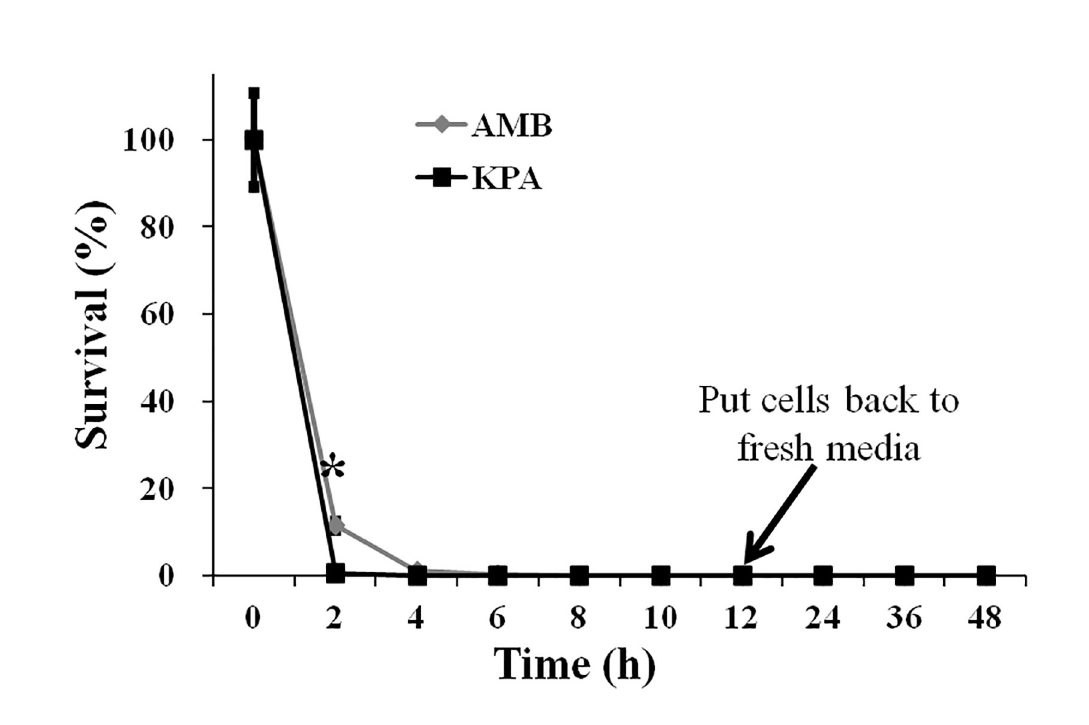
Fig 2. The time-killing curves of KPA and AMB against wild type C . albicans strain SC5314. Data represent mean values and error bars show standard deviations.